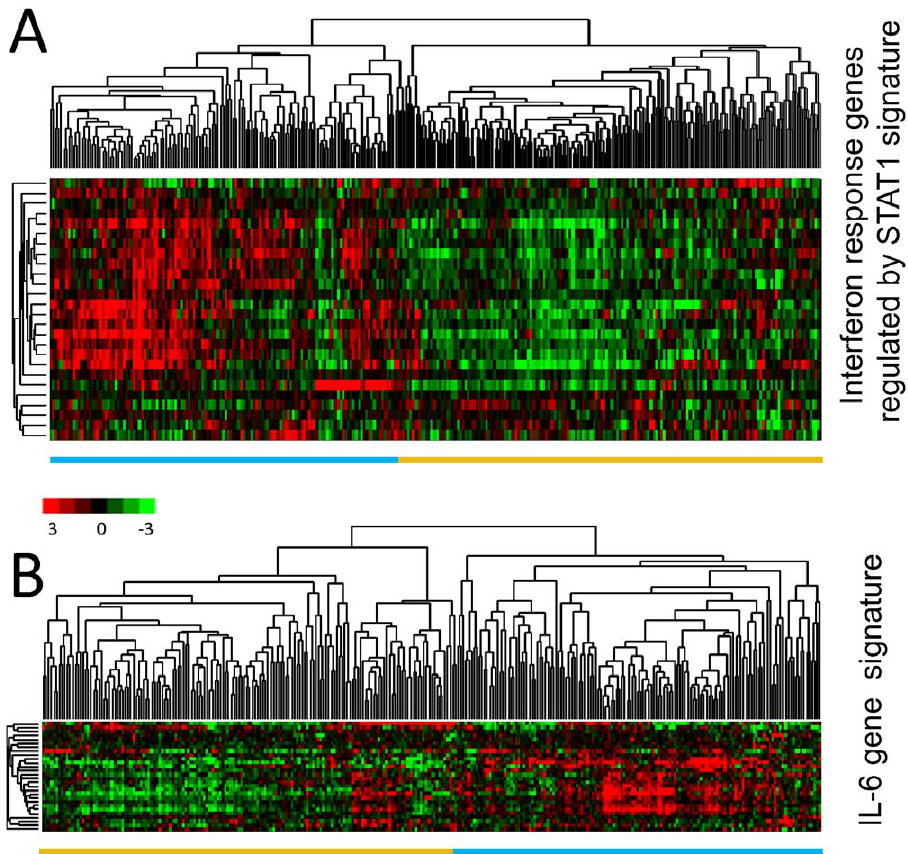
Figure 4. ‘‘Interferon response genes regulated by STAT signature’’ and ‘‘IL-6 gene signature’’ in early stage breast cancer. ( A ) The expression values of genes in the ‘‘interferon response genes regulated by STAT1 signature’’ were extracted from a published gene expression study of 295 early stage breast cancers from the Netherlands Cancer Institute [24]. Genes and samples are organized by unsupervised hierarchical clustering. The tumors segregated into two groups defined by high (blue bar below the heatmap) or low (golden bar below the heatmap) expression levels of 26 genes matching the ‘‘interferon response genes regulated by STAT1 signature’’. ( B ) For the ‘‘IL-6 gene signature’’ an analogous analysis was performed, resulting in tumors segregated into two groups based on the expression levels of 28 genes. The two main clusters of tumors with high and low expression levels are marked with colored bars below the heatmap (blue and golden respectively).